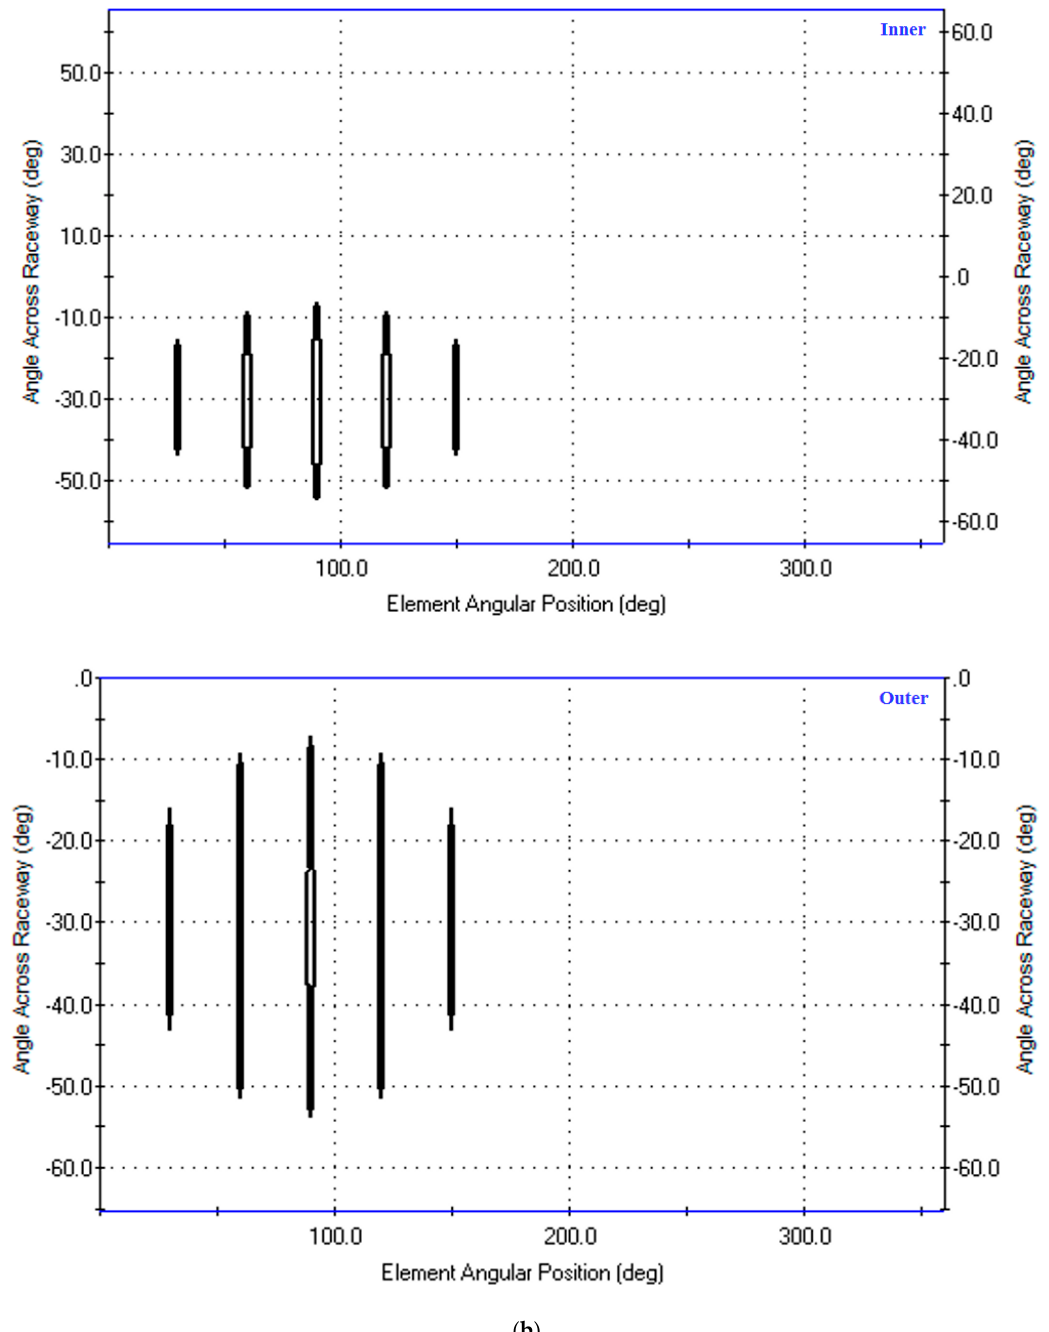
Figure 15. Contact footprint between balls and raceways under test load condition. ( a ) Inner / Outer raceway of row 1 ( b ) Inner / Outer raceway of row 2.